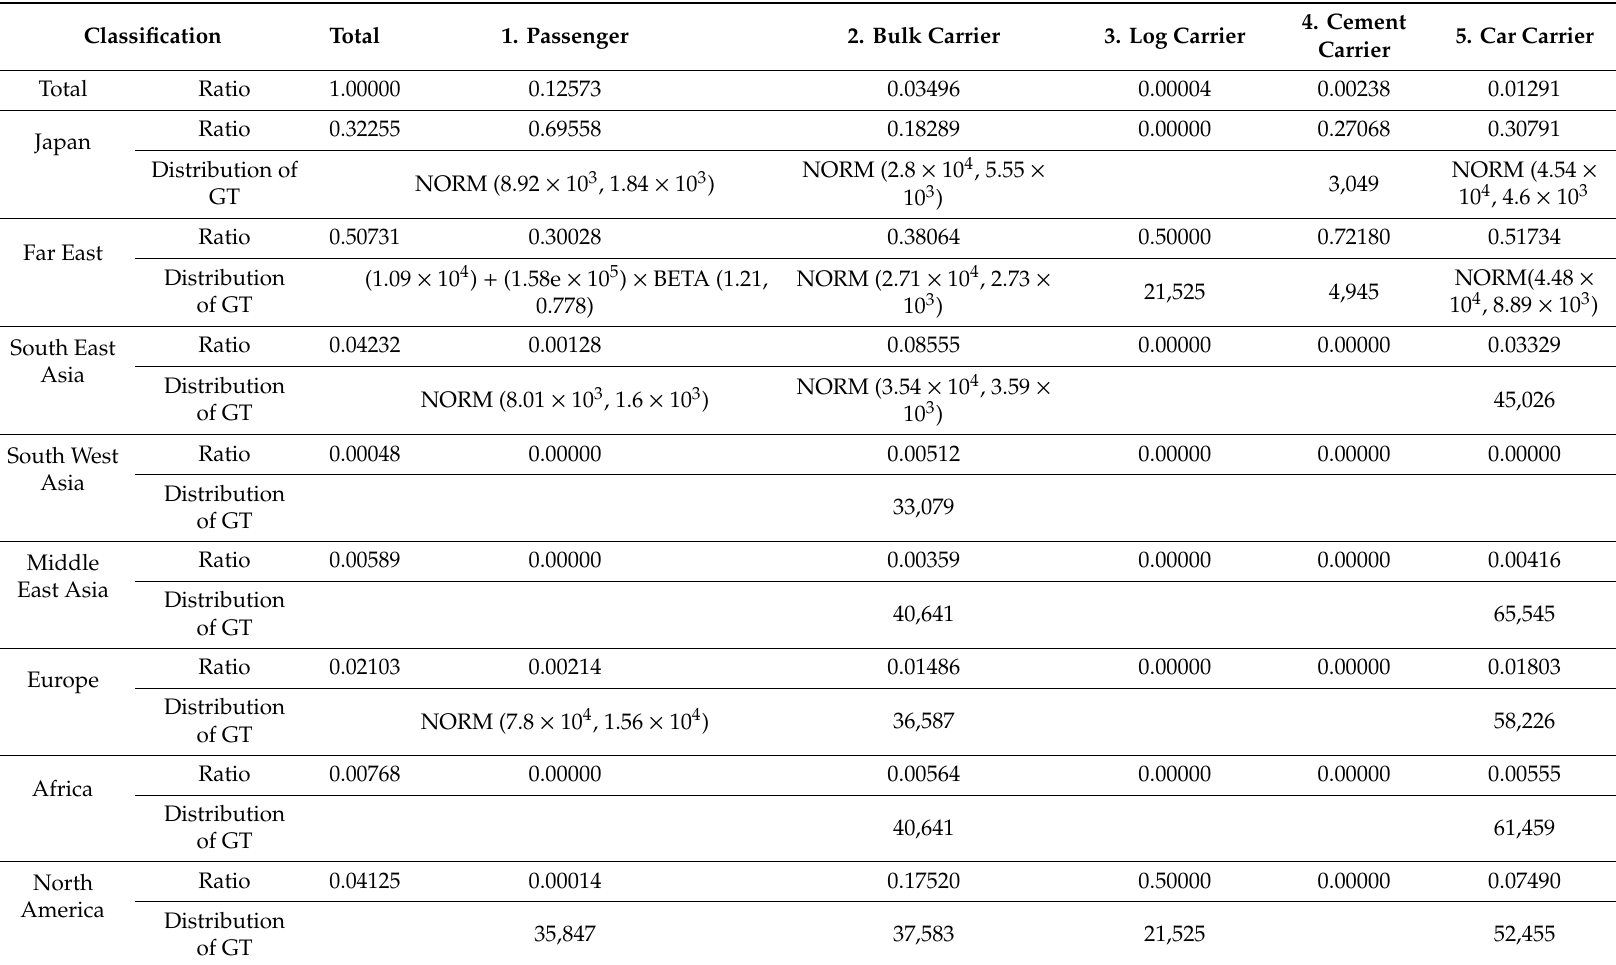
Table A4. Distribution and Ratio per 12 Navigation Zones per 16 Ship